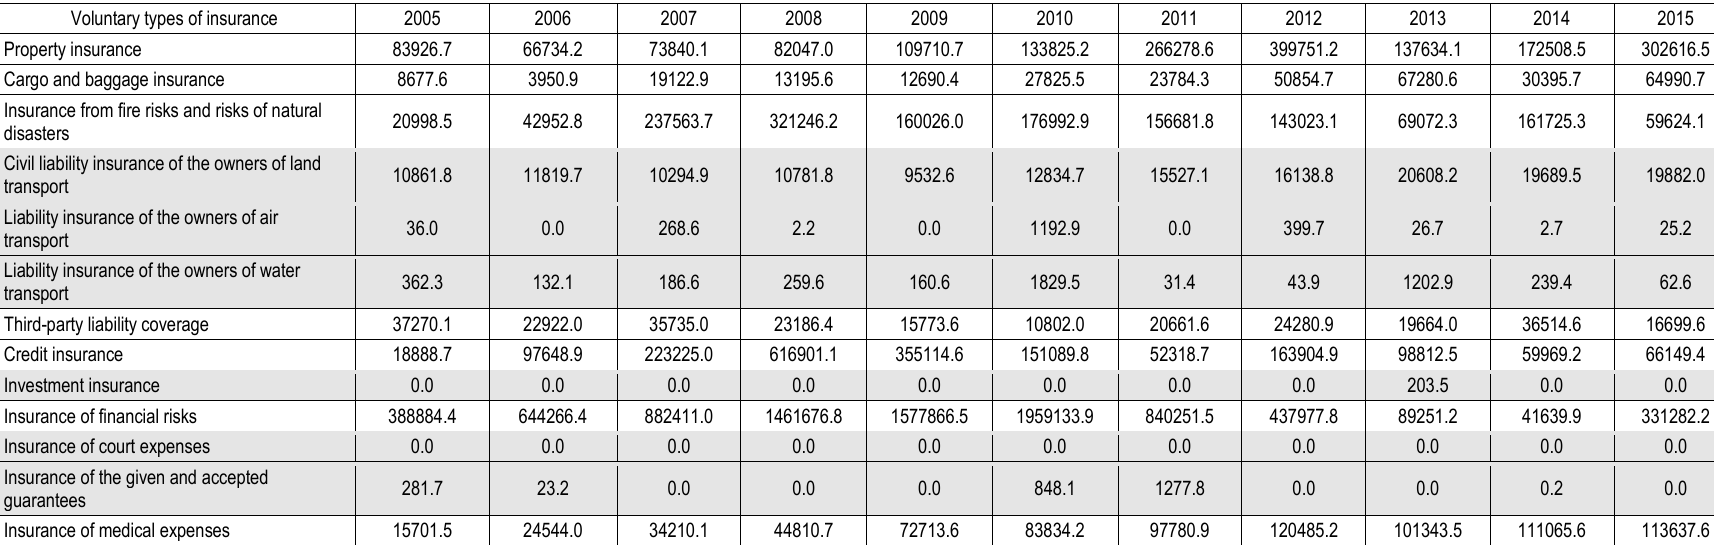
Table 2 (cont.). Net insurance payments for certain types of insurance in 2005 – 2015, thousand UAH.